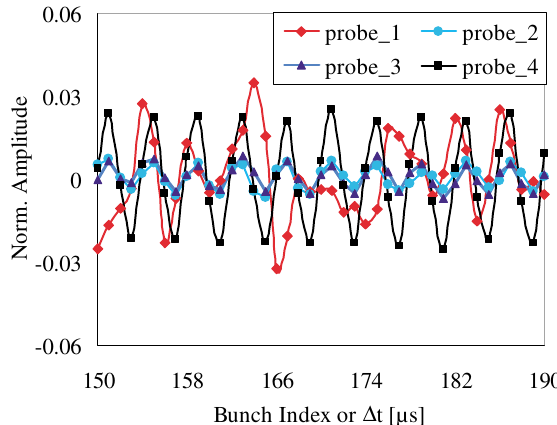
FIG. 7. (Color) Prototype P2. Oscillations of signals (normal- ized) during the acceleration.